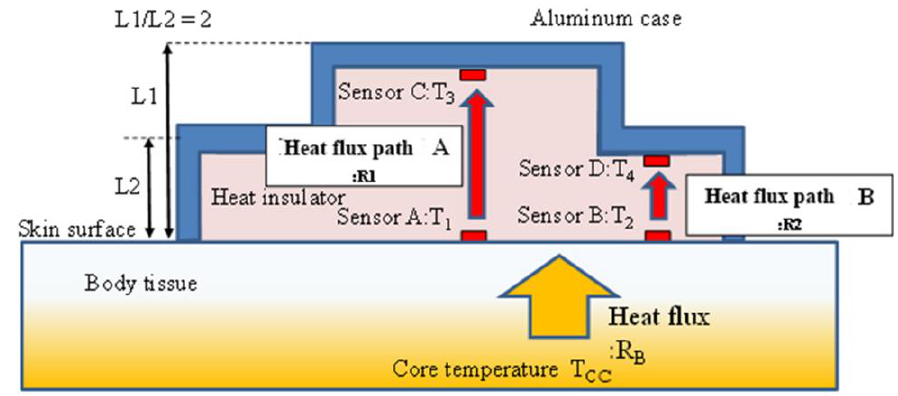
Figure 2. Principle of the dual-heat-flux thermometer.